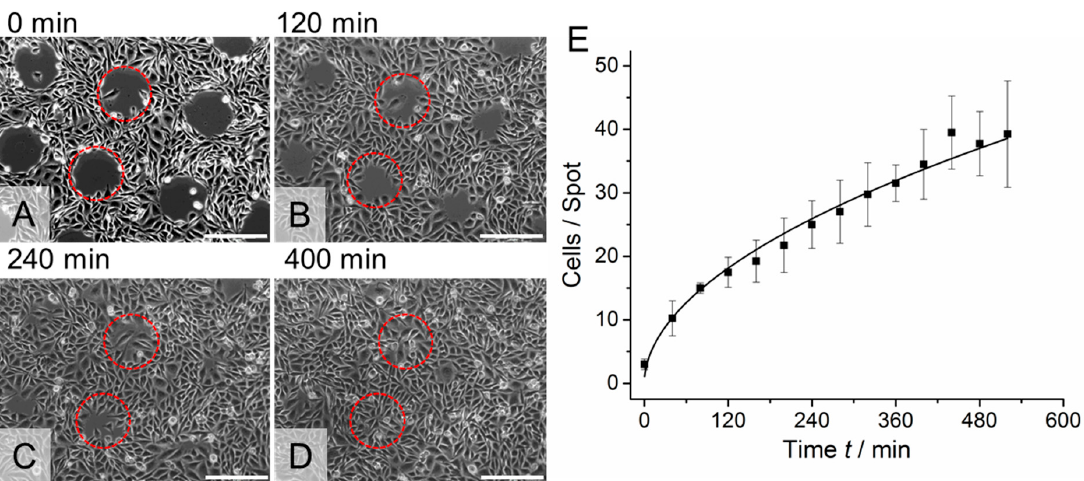
Figure 3. Representative images of time lapse microscopy of CHO-K1 epithelial cells on patterned thermoresponsive microgel substrates. ( A ) The cell patterning was achieved by detachment of cells from the microgel spots after the sample was incubated for 30 min below the lower critical solution temperature (LCST) at 22 °C. Cells attached on the uncoated areas remained on the substrate. When the temperature was increased to 37 °C, the cells started to migrate to the now cell-free regions ( B , C ) and formed a closed cell monolayer after 400 min ( D ). Two representative microgel coated areas per picture are indicated by red circles. Scale bars: 200 µm. ( E ) Quantification of the cell migration onto the microgel spots at 37 °C as a function of time. ( A ) adapted with permission from [11]. Copyright 2016 American Chemical Society.